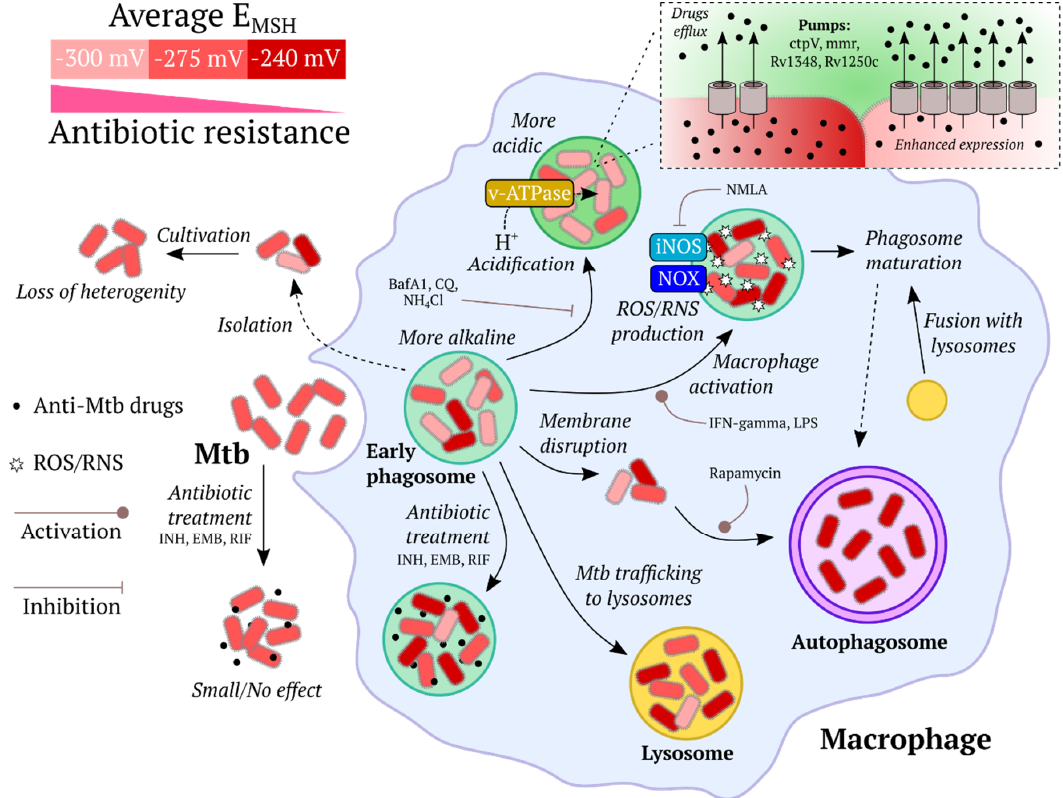
Figure 10. Internalization of Mycobacterium tuberculosis (Mtb) cells into macrophages leads to the emergence of subpopulations with different mycothiol redox potential ( E MSH ). Subsequent phagosome maturation is followed by an increase of the “oxidized” fraction size. Phagosomal acidification and antibiotic treatment also affect the average E MSH value. It is important to note, that the latter correlates with antibiotic resistance which is partially attributed to the differences in drug-efflux pumps expression [49,52]. Abbreviations: CQ—chloroquine; EMB—ethambutol; IFN—interferon; INH—isoniazid; iNOS—inducible NO synthase; LPS—lipopolysaccharides; NOX—NADPH oxidase; RIF—rifampicin; RNS—reactive nitrogen species; ROS—reactive oxygen species.